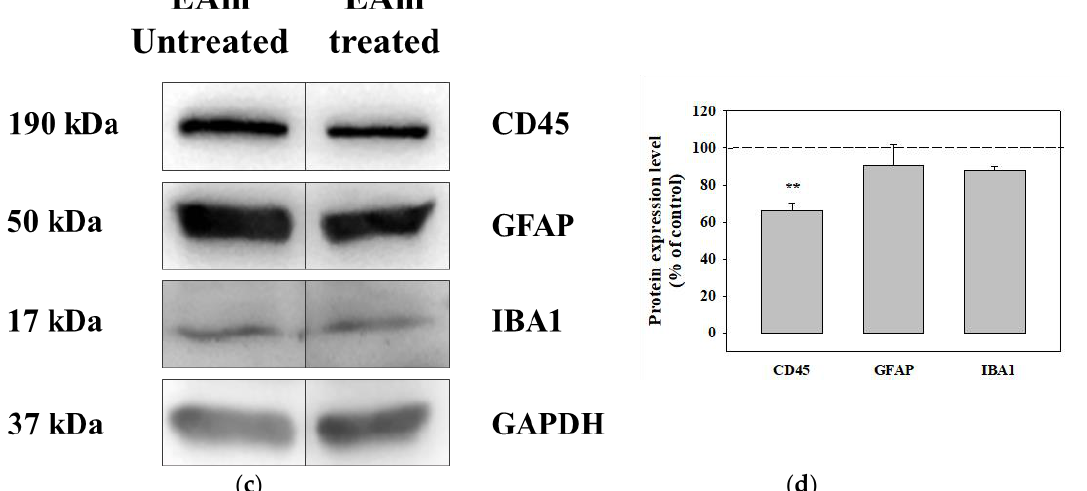
Figure 6. Effects of EAm treatment on the expression of the CD45, of the glial fibrillar astrocytic protein (GFAP), and of the ionized calcium binding adaptor molecule 1 (IBA-1), in cortical lysates from young and old mice. ( a ): representative blots of the GFAP, IBA-1 and CD45 immunostaining in cortical lysates from EAm-untreated and EAm-treated young mice. The GAPDH protein was used as internal control. ( b ): quantification of the change in CD45, GFAP and IBA-1 immunostaining in cortical lysates from EAm treated young mice, versus EAm untreated mice. Results are calculated as respective protein ÷ GAPDH ratio and are expressed as percentage of the EAm untreated mice. ( c ) representative blots of the GFAP, IBA-1 and CD45 immunostaining in cortical lysates from EAm-untreated and EAm-treated old mice. ( d ) as for (b), but for old mice. The blot is representative of five blots for young mice (seven EAm-untreated and seven EAm-treated young mice) and of five blots for old mice (eight EAm-untreated and 7 EAm-treated old mice) carried out in different days. Statistical analysis was performed by applying ANOVA followed by Student t test analysis for direct comparison * p < 0.05 vs. respective control; ** p < 0.01 vs. respective control; *** p < 0.001 vs. respective control.